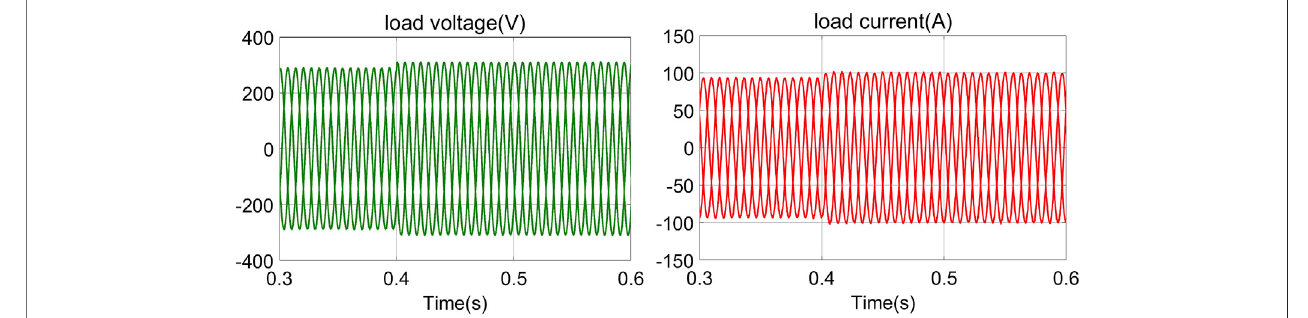
FIGURE 5 | Load voltage and current.